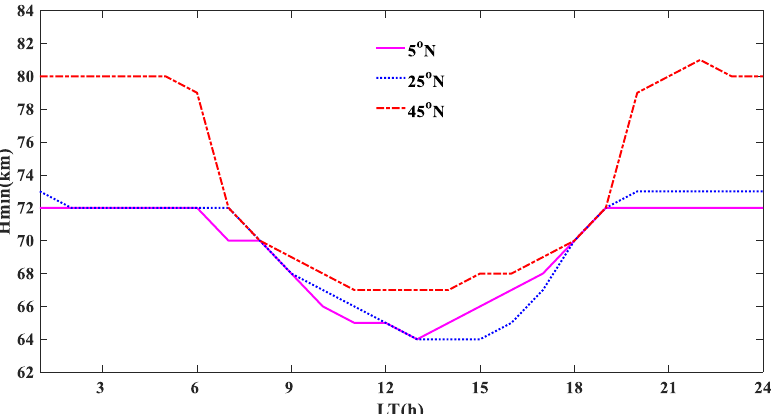
Figure 6. The electron density of the physical model varies with the altitude at 4:00 LT, 9:00 LT, 13:00 LT, 17:00 LT, and 22:00 LT in the mid-low latitude region (5°N, 25°N, and 45°N).